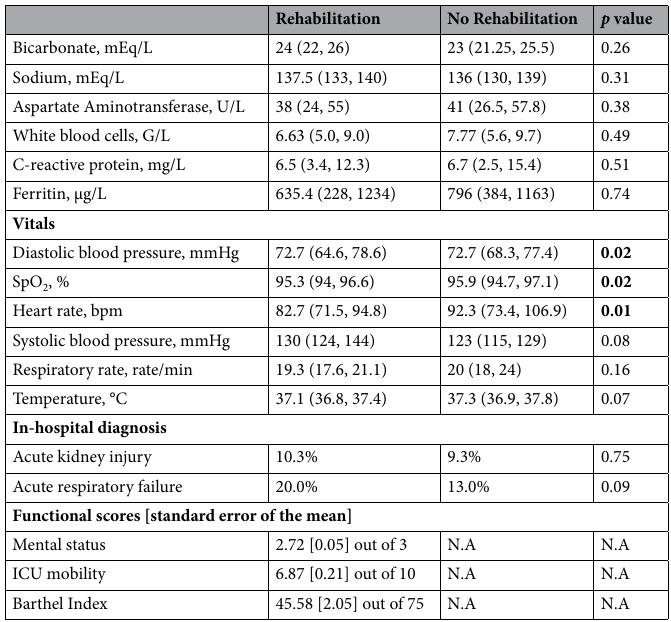
Table 1. Demographics, comorbidities, symptoms, laboratory tests, and vitals in the rehabilitation (N = 155) and non-rehabilitation (N = 162) group at hospital admission. Group comparison of categorical variables in percentages used Chi-square tests. Group comparison of continuous variables in medians and interquartile ranges (IQR) used the Mann–Whitney U test. Functional scores are represented as mean [SEM]. p values in bold indicate statistical significance. N.A. indicates not available. COPD: chronic obstructive pulmonary disease, GI disease: Gastrointestinal disease.